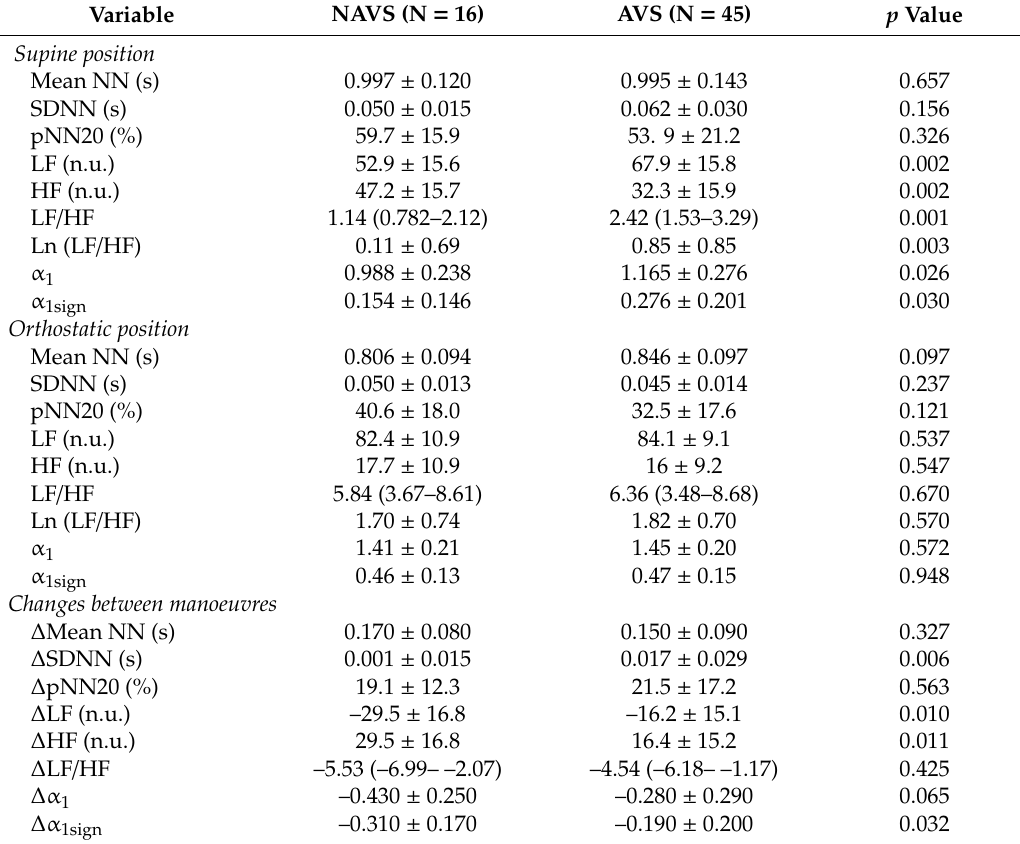
Table 4. Heart rate variability